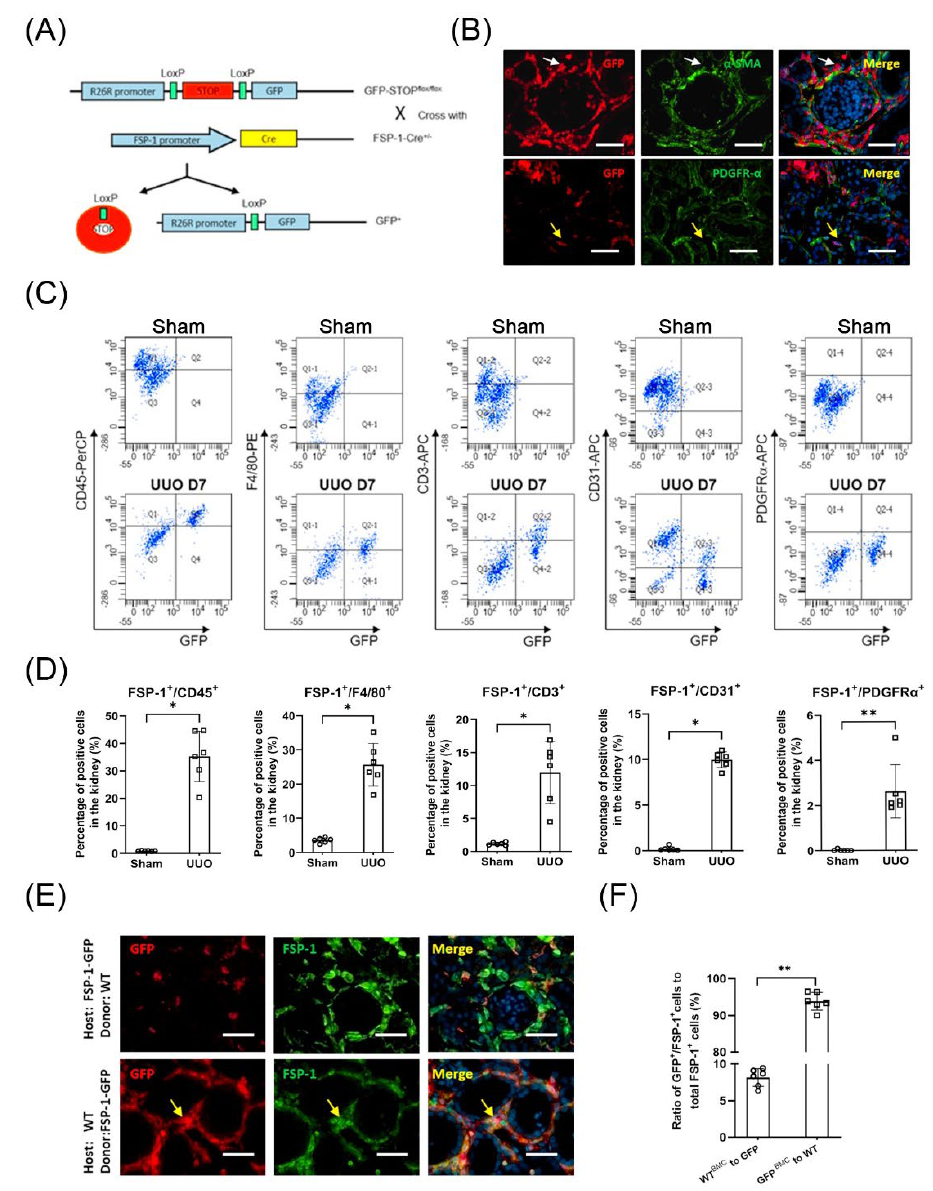
Figure 3. Characterization of FSP-1 + cells in obstructed kidneys. ( A ). Schematic of breeding of FSP-1 GFP reporter mice. ( B ). Double immunostaining of GFP with α -SMA or PDGFR α in obstructed kidneys of FSP-1 GFP mice. The arrows indicate that the GFP + cells were not co-localized with α -SMA + or PDGFRα + cells. ( C , D ). Flow cytometry and quantification analysis of FSP-1 + cells. Most FSP-1 + cells were positive for CD45 + (hematopoietic cell marker) or F4/80 + (macrophage marker) in obstructed kidneys after 7 days of UUO. (*, p < 0.05 vs. sham; **, p < 0.005). ( E , F ). FSP-1 + cells found in UUO are BM-derived. Double Immunostaining of GFP and FSP-1 was performed in the obstructed kidneys of WT mice transplanted with BM from an FSP-1 GFP mouse or FSP-1 GFP mouse transplanted with BM from WT mice (yellow arrows point to FSP-1 + /GFP + double-positive cells ( E ). The ratio of GFP + /FSP-1 + double-positive cells in obstructed kidneys was counted and calculated ( F ) (**, p < 0.005). Bar = 50 μm in panels ( B , E ); data are expressed as mean ± SEM, n = 6 mice; GFP, green fluorescent protein; PDGFR, platelet-derived growth factor receptor; SMA, smooth muscle actin.